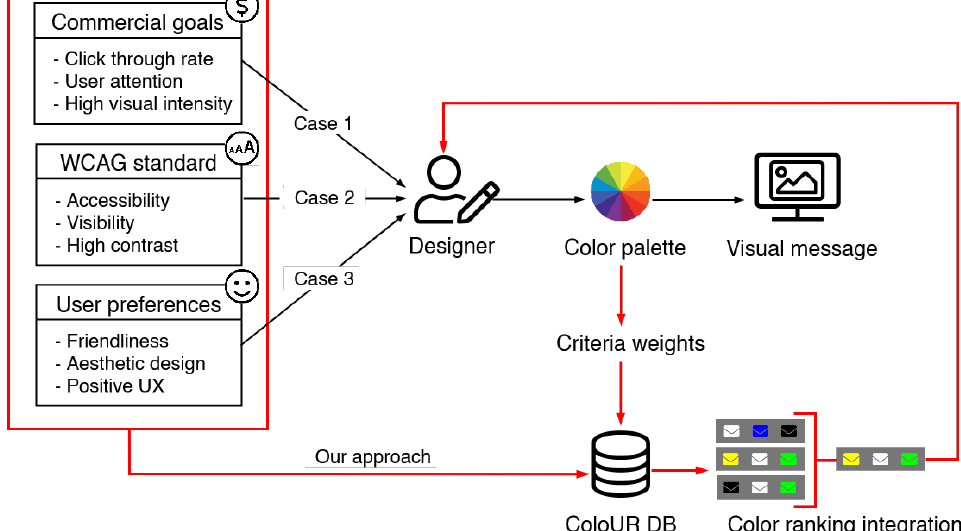
Figure 1. A designer must take numerous factors into account. On one hand, their work represents the implementation of their creative vision, while on the other hand, business requirements, standards, and technological limitations must be considered. The fulfillment of business targets is measured by the attainment of a high click-through rate (CTR) [11] through the use of visual design to attract the user’s attention, especially in the color domain (Case 1). Trends, as well as standards, such as the WCAG, impose visual design adjustments on different social groups by, e.g., limiting the color palette to colors with a high contrast factor (Case 2), whereas the user follows their preferences and expects a friendly and aesthetic visual message, which is simultaneously legible and comprehensible (Case 3). Thus, the search for a solution that balances user preferences, the attraction of user attention, and the fulfillment of WCAG standards takes place. The used dimensions are subjective data, objective measurements, and color contrast. Data collected during the experiment are stored in a knowledge database, called ColoUR DB (Color User Response Database). The designer decides which criteria are relevant for a given visual design and adjusts their weights appropriately. Based on the designer’s settings, a color ranking is generated. It is possible to obtain a color ranking for each separate criterion as well as an integrated one that covers all designers’ settings. The results were used to develop and implement a tool for designers, which we call The ColoUR Balance